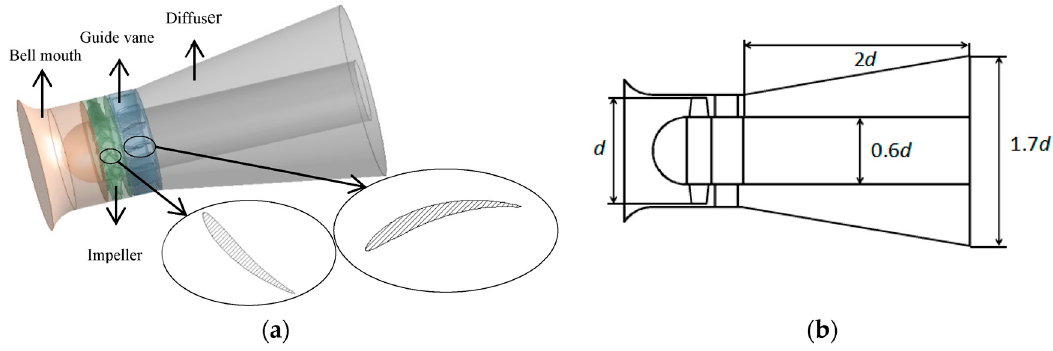
Figure 1. Model of the axial flow fan of type OB-84. ( a ) physical model; ( b ) dimensions of the fan.